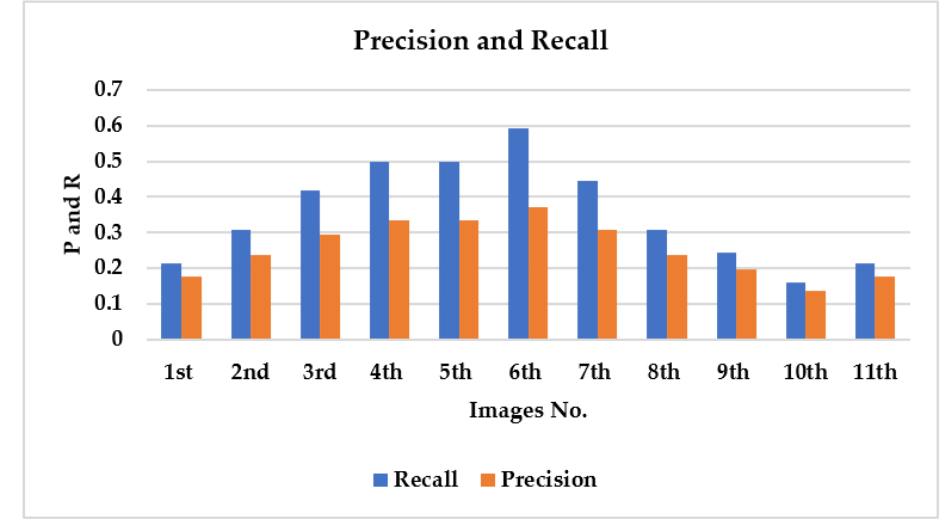
Figure 26. Precision and recall computed for ImageNet-Sketch dataset based on InfoGAN.